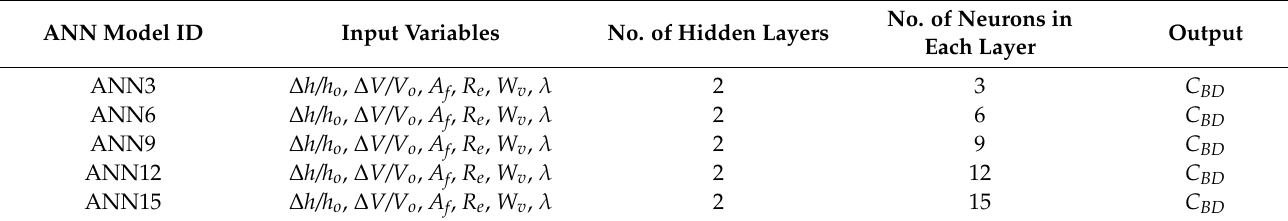
Table 2. Presentation of ANN model inputs and